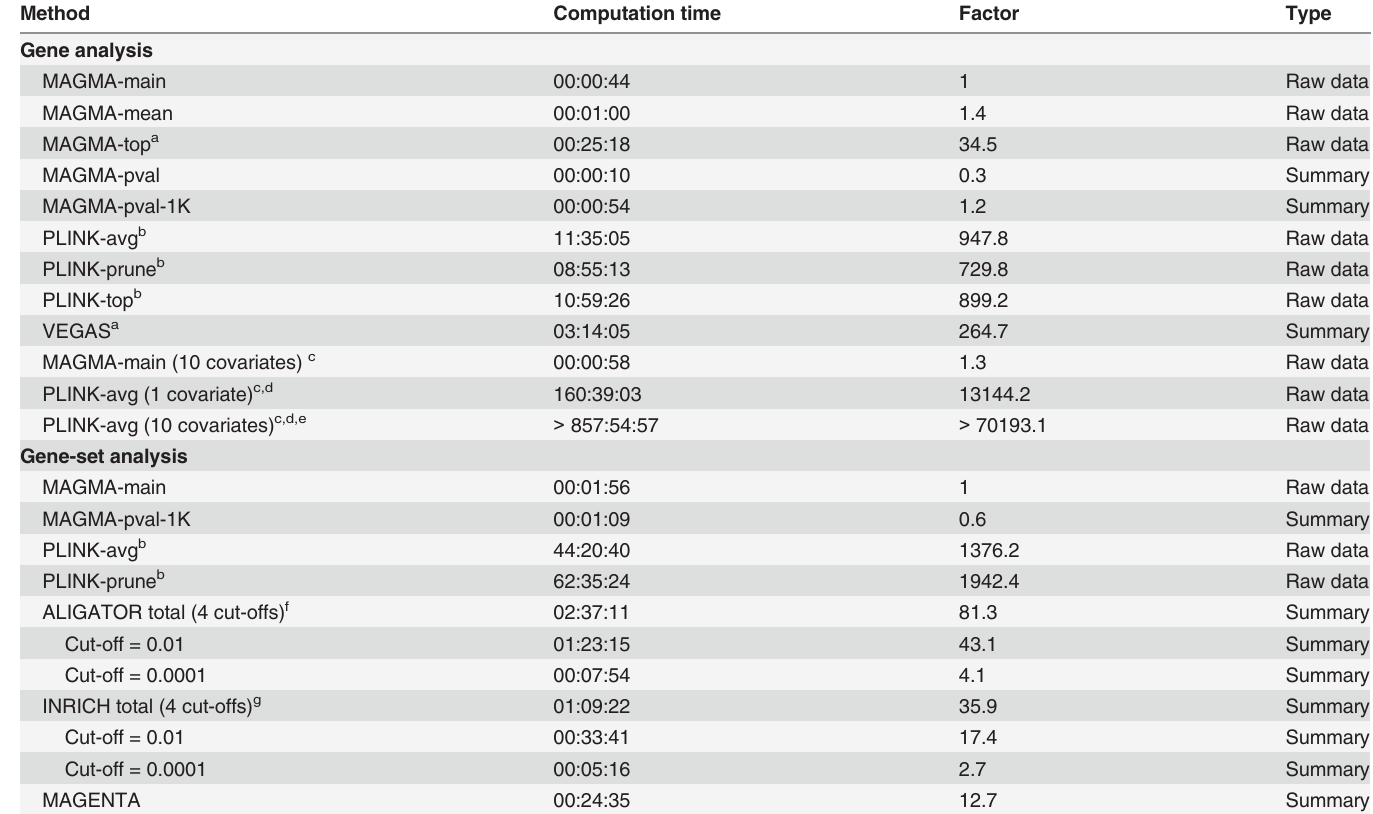
Table 5. Computation times for gene and gene-set